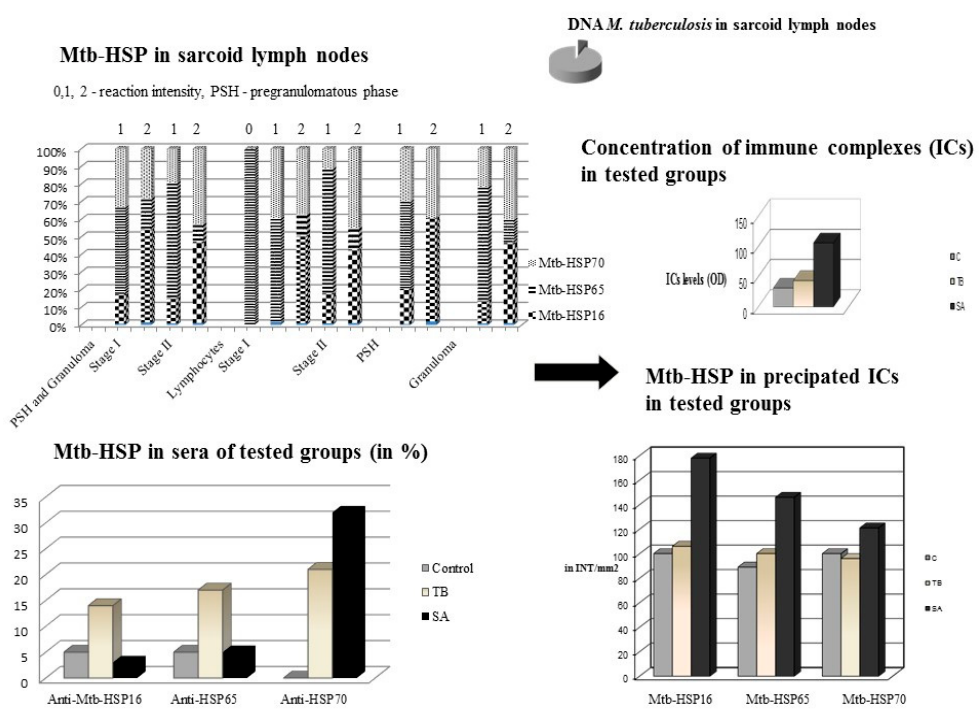
Figure 2. The presence of mycobacterial heat shock proteins in lymph nodes, sera, and in precipitated immune complexes in patients with SA, patients with TB and the